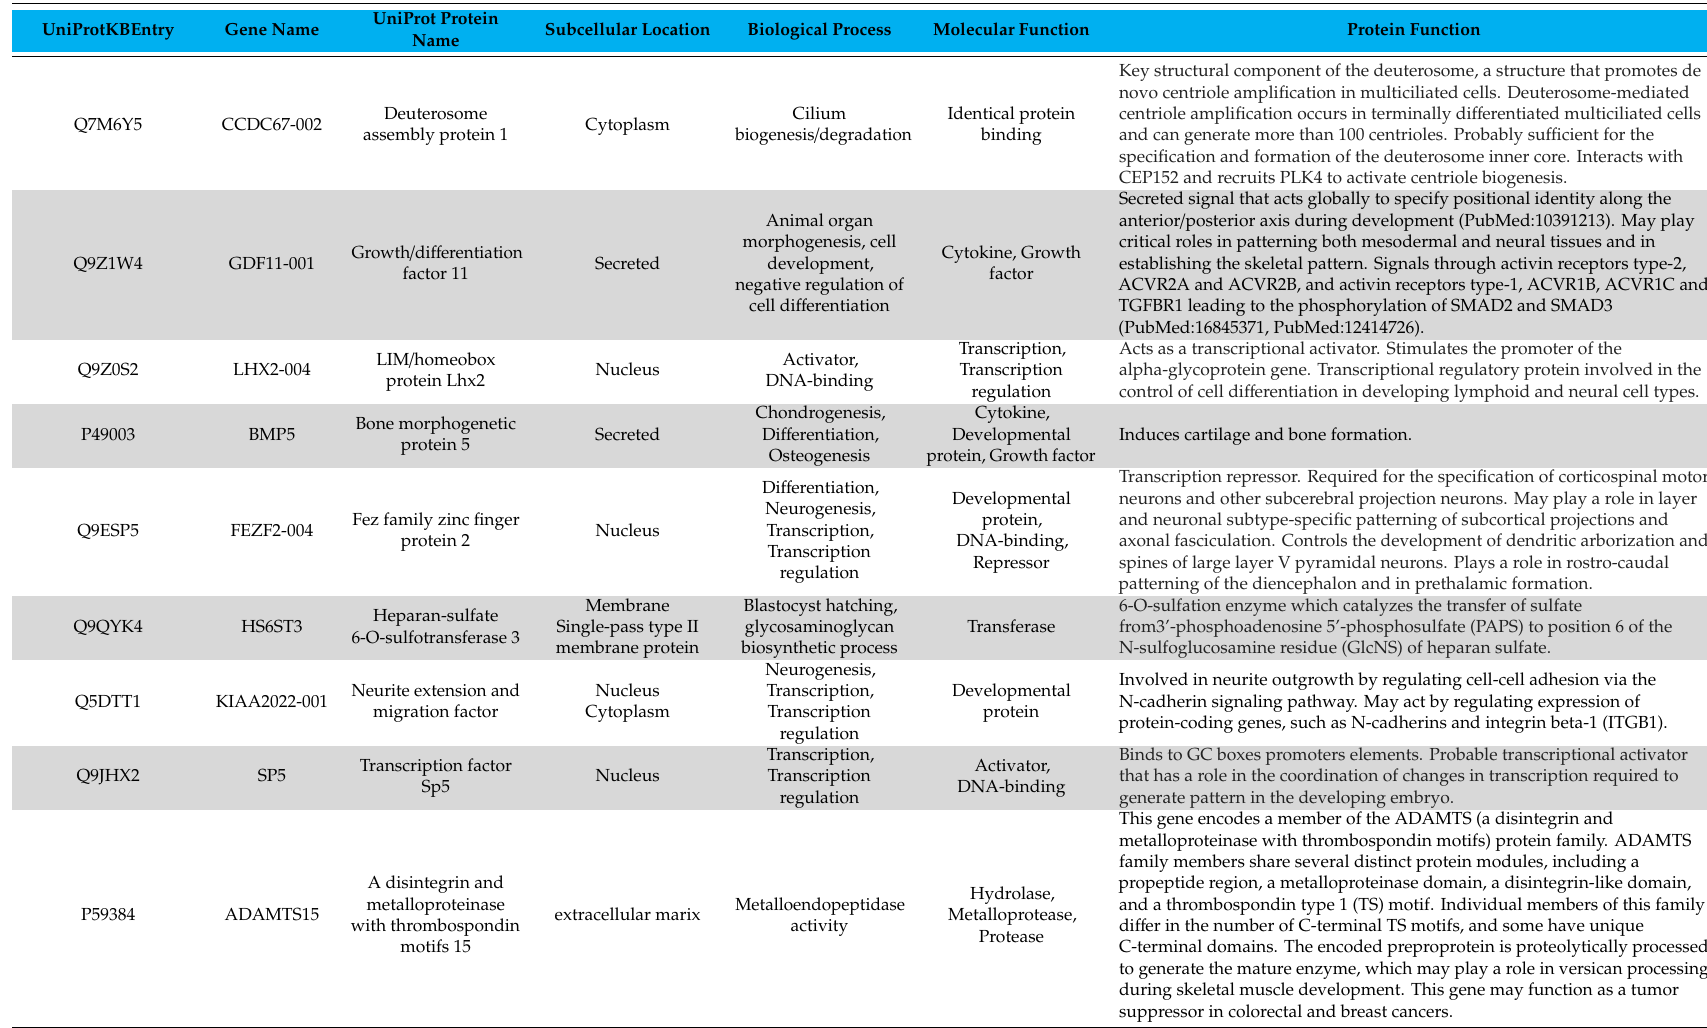
Table 8. Summary of protein function corresponding to